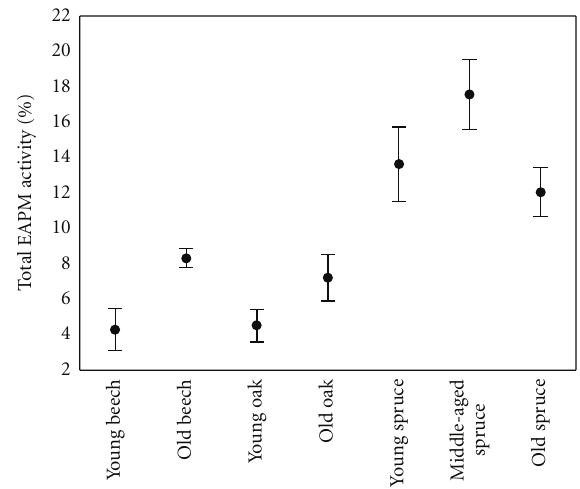
Figure 2: Proportion of root-derived EAPM within total soil EAPM up to 15 cm depth (Mean ±